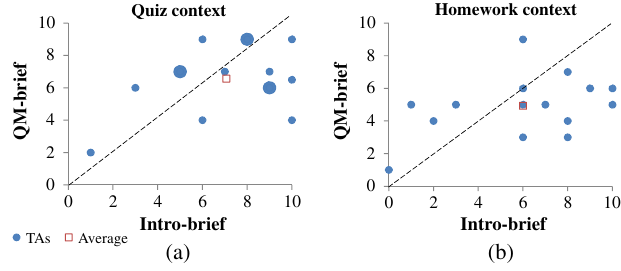
FIG. 6. (a) Distribution of individual scores assigned to the elaborated solutions QSS-E (QM) versus ISS-E (Intro) in the quiz context ( p ¼ 0 . 307 ). (b) Individual scores assigned to the elaborated solutions QSS-E (QM) versus ISS-E (Intro) in the HW context ( p ¼ 0 . 625 ). The relative size of the bubble represents the number of TAs at a particular point.